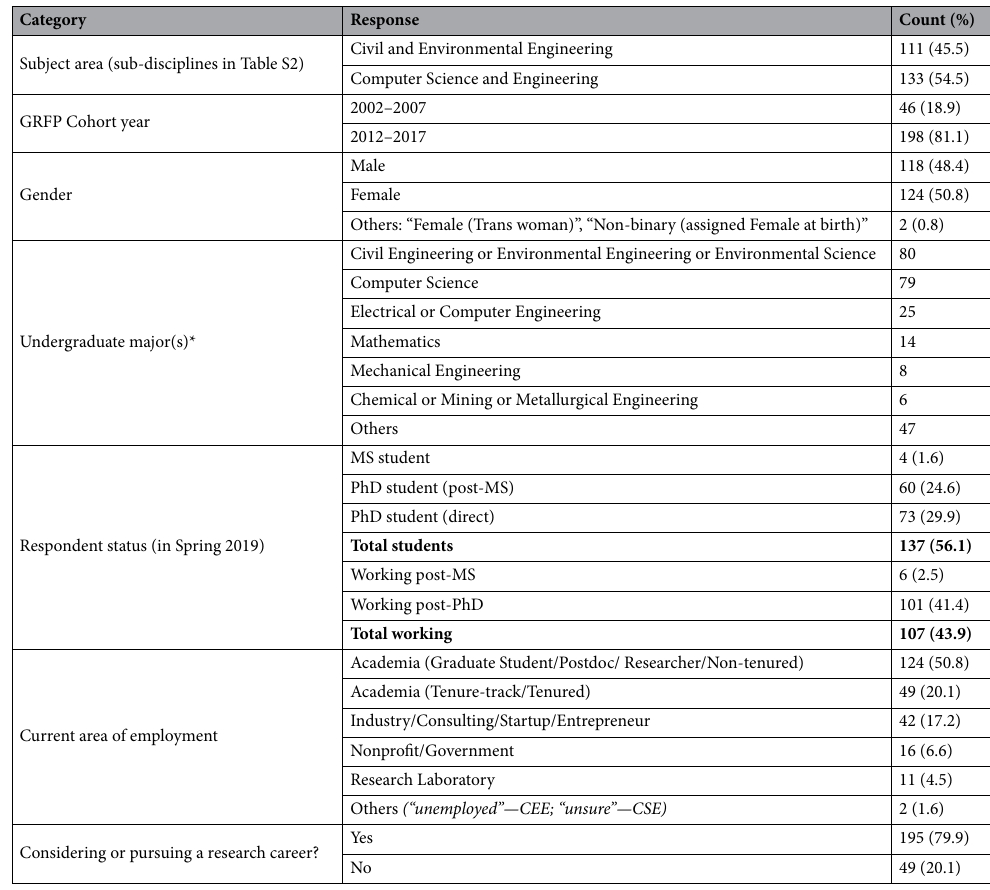
Table 1. Demographics. Summary of NSF Fellow respondents on this survey. *Total # of undergraduate majors reported exceeds total # of NSF fellows (244), because 14 fellows reported at least two majors (one fellow reported three).